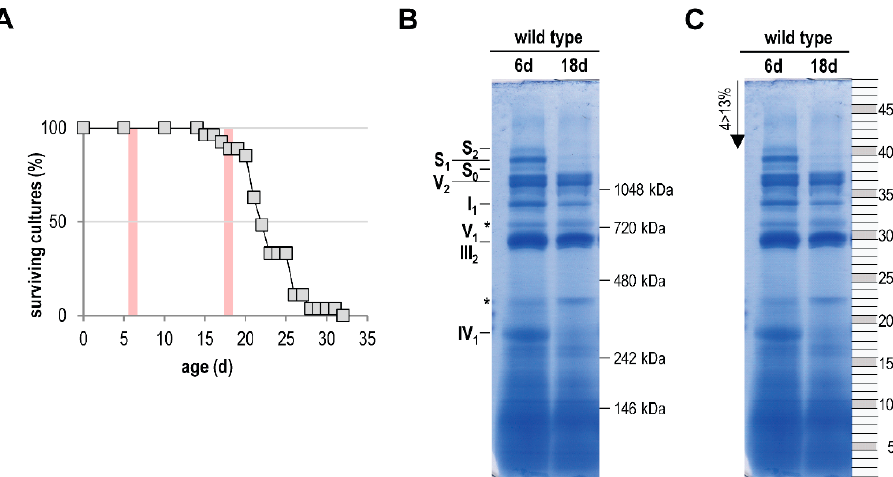
Figure 1. Age ‐ dependent reduction of respiratory chain complexes. ( A ) Survival curve of P. anserina wild type ( n = 15) grown on M2 medium under standard growth conditions. Red bars mark the time points used for further investigations. ( B ) BN ‐ PAGE analysis of isolated mitochondria from 6 ‐ day ‐ and 18 ‐ day ‐ old wild ‐ type cultures (each sample was pooled from the mitochondria of two different cultures). Mitochondria were solubilized with digitonin (ratio: digitonin to protein 4 g/g). The CI 1 CIII 2 CIV 0–2 (S 0–2 ) supercomplexes, dimeric complexes III and V (III 2 and V 2 ), as well as monomeric complexes I 1 , IV 1 , and V 1 were visualized using Coomassie staining. Asterisks (*) mark uncharacterized protein bands. ( C ) For complexome profiling the BN ‐ PAGE lanes were cut horizontally from the lower to the upper site in 48, almost equally sized, pieces. The numbers of the single fractions are indicated on the right.